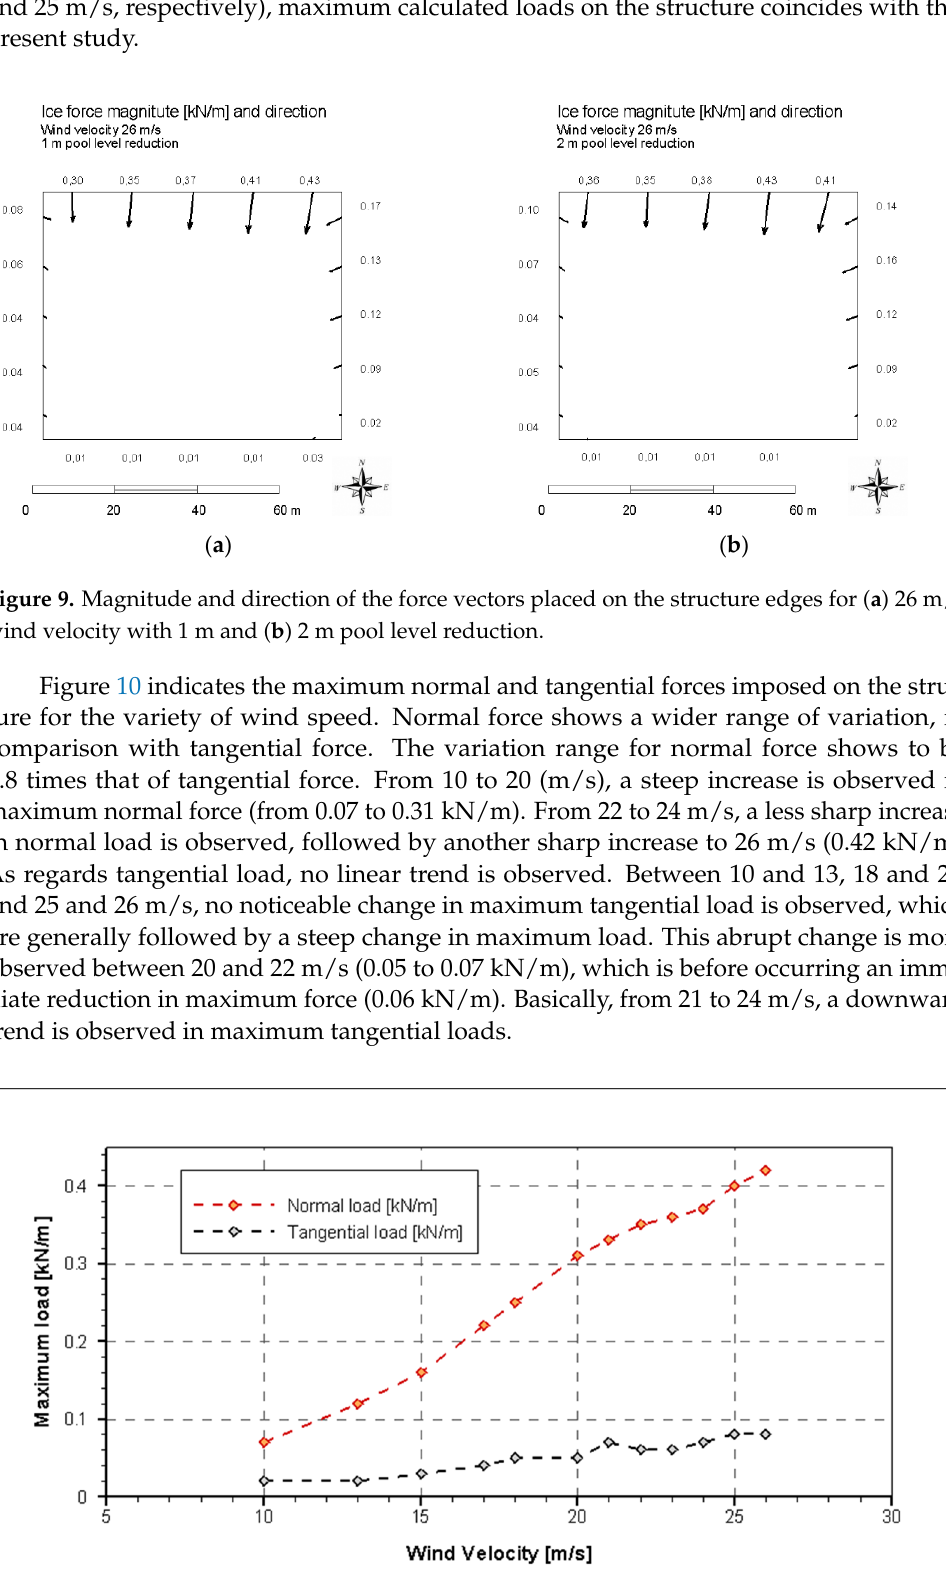
Figure 10. Maximum normal and tangential load imposed on the structure for the variety of wind speed.